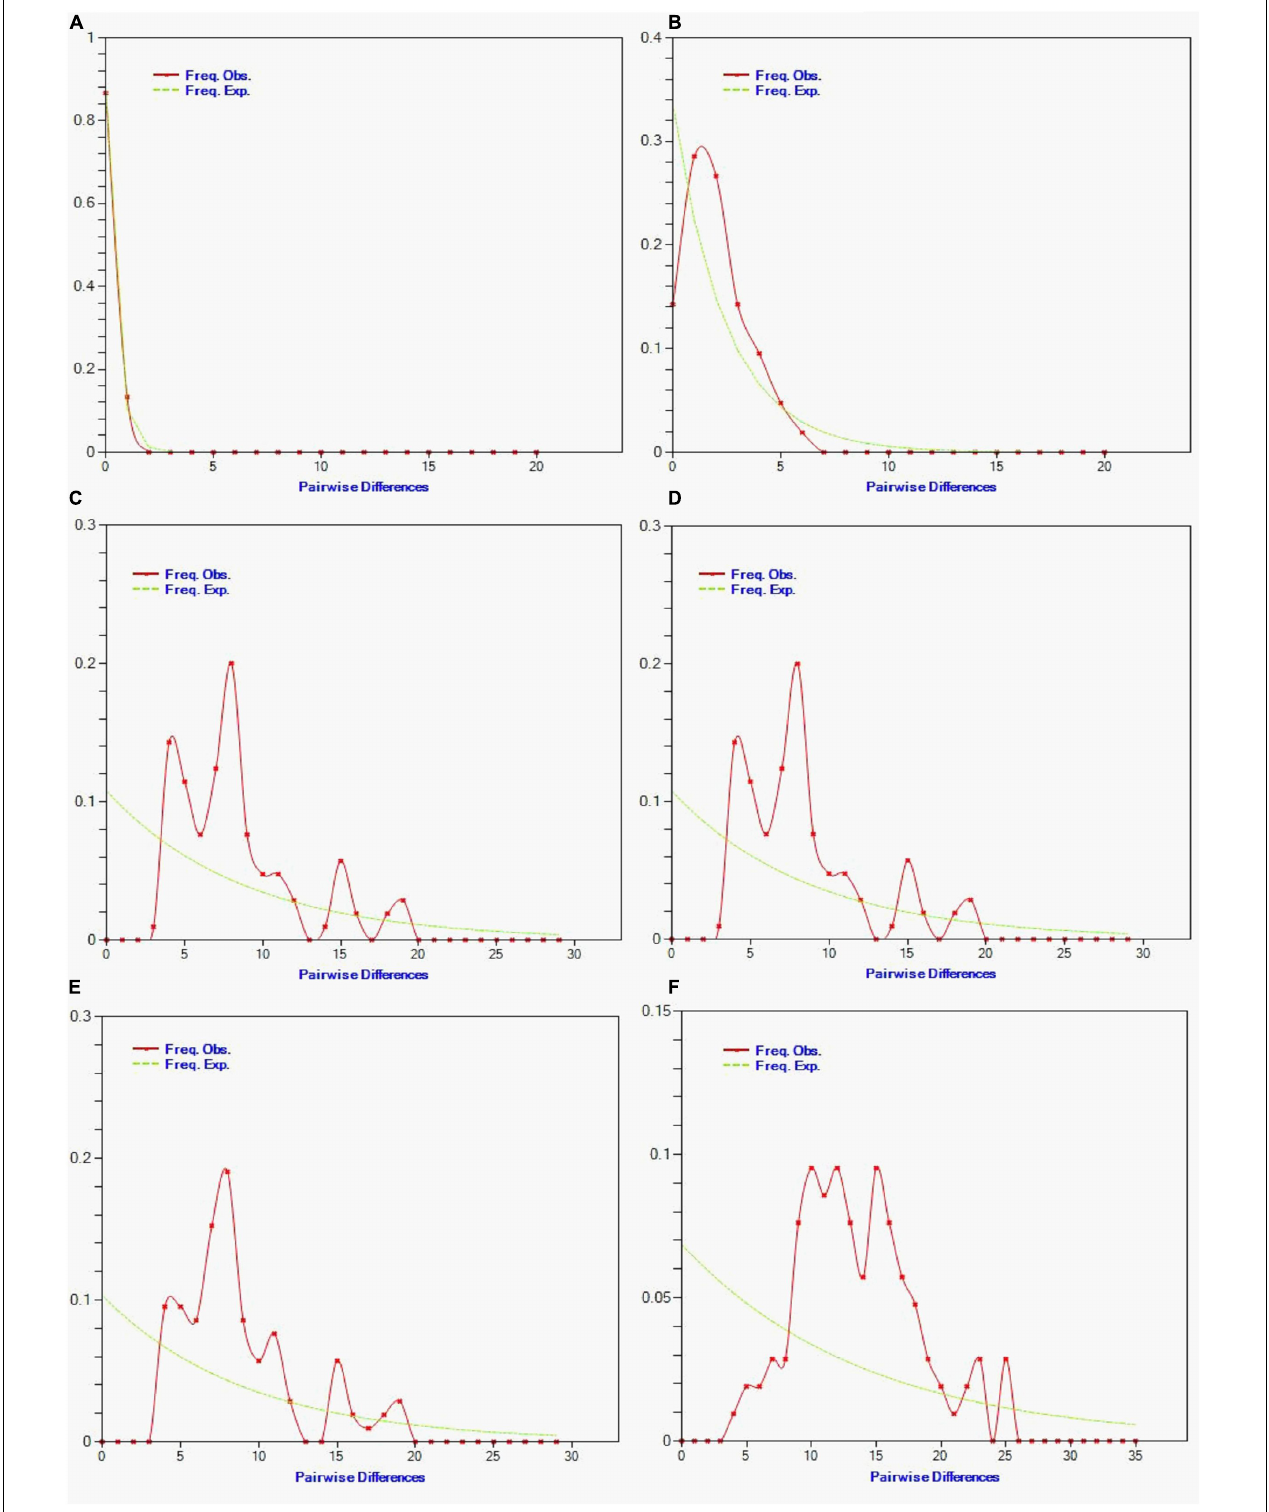
FIGURE 9 | Observed pairwise differences (red line) and the expected mismatch distributions under the sudden expansion model (green line) for Tenualosa ilisha of (A) Kali river, (B) Gaglajur Haor, (C) Padma river, (D) Meghna river, (E) Tetulia river, and (F) Bay of Bengal. The X -axis show the number of pairwise differences and the Y -axis shows the frequency of the pairwise